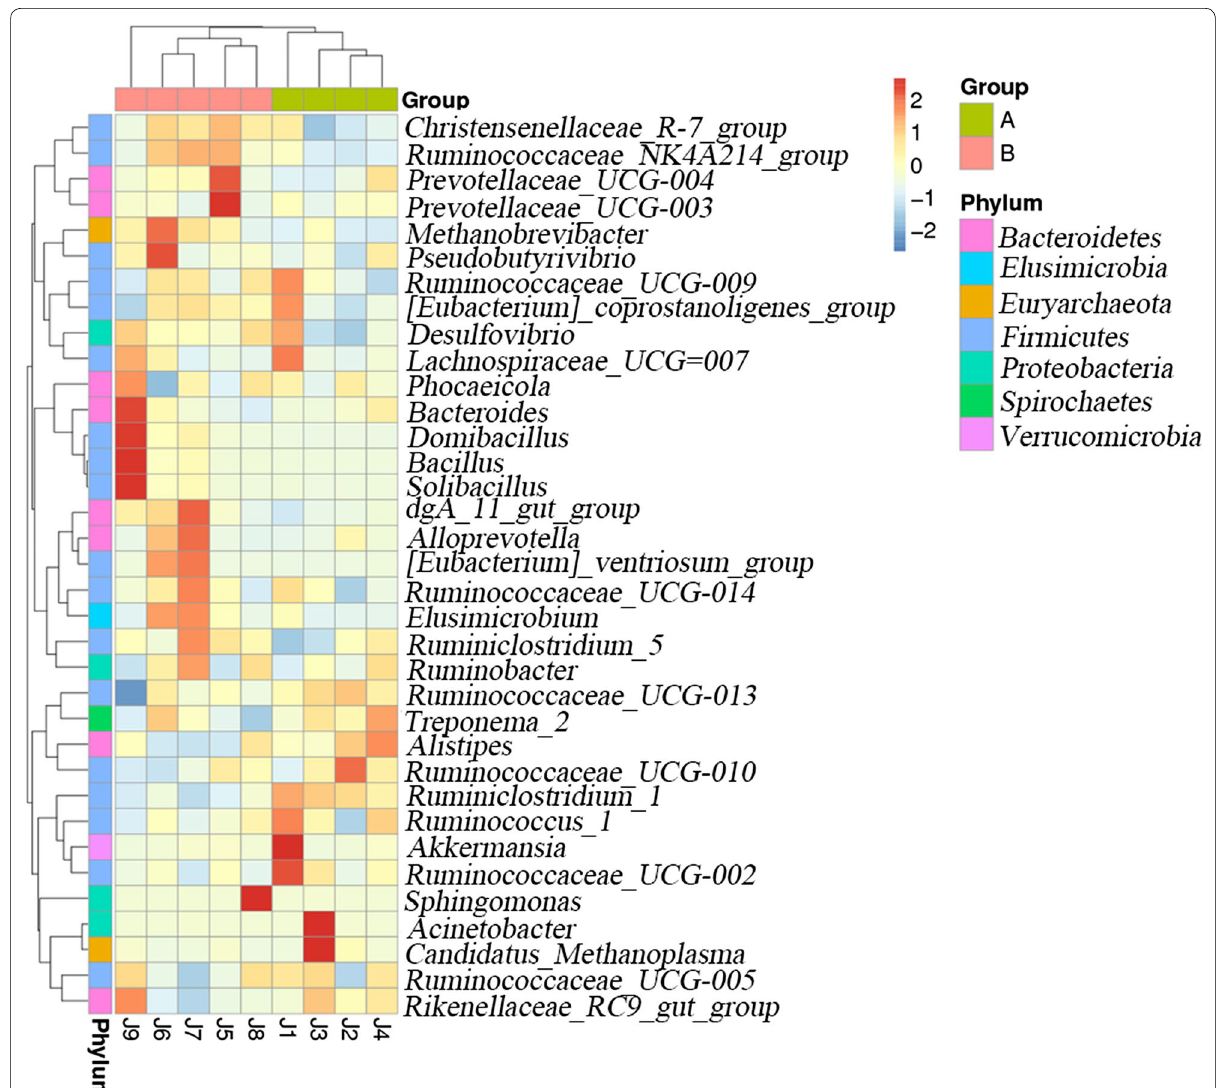
Fig. 4 Double dendrogram showing the bacterial distribution among the fecal samples of nine golden takins. The abundances of the top 35 gen- era were sorted for the analysis. The heatmap plot depicts the relative percentage of each bacterial genus (variables clustering on the y-axis) within each sample (x-axis clustering). The relative values for the bacterial genus are depicted by color intensity in the legend indicated at the top right of the figure. Clusters based on the distance of the nine samples along the x-axis and the bacterial genera along the y-axis are indicated in the upper part and left of the figure, respectively. Different colors on the x-axis represent different groups, and different colors on the y-axis represent which phylum they belong to. The meaning of the different colors is indicated at the top right of the